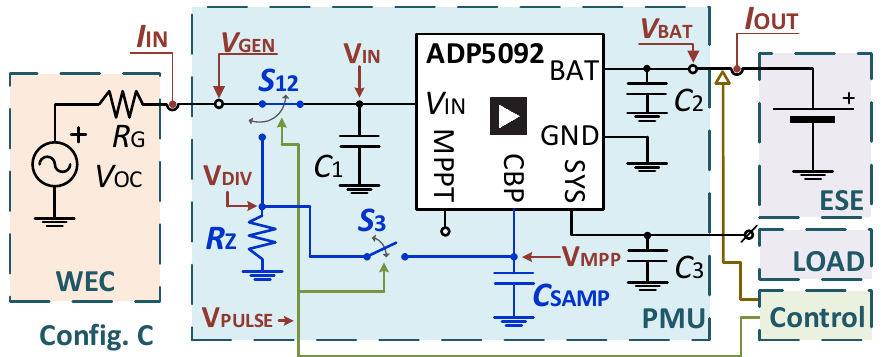
Figure 4. FOCV-MPPT con fi g. C circuit presented in [17], together with the WEC’s electrical model as the input source and an ESE as the sole output load.